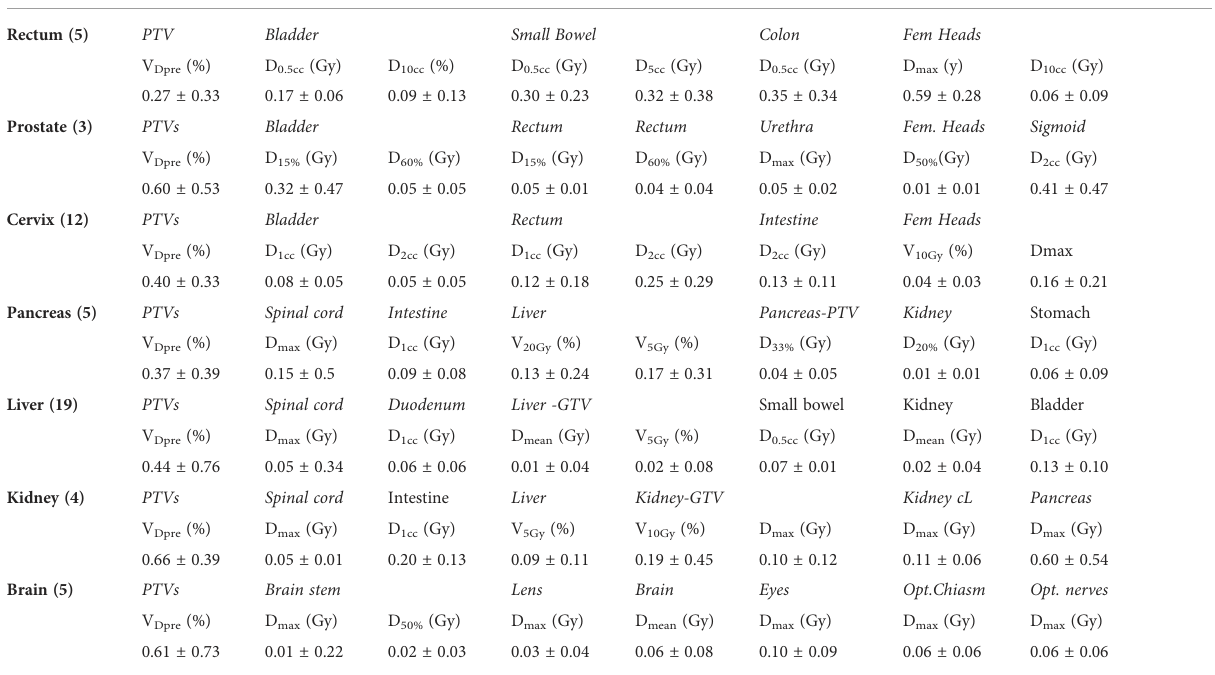
TABLE 3 Absolute difference of CT vs. syCT targets and OARs DVH dosimetric parameters (mean and standard deviations) for 54 out of 61 patients, resulting in tolerance at the fi rst CT vs. syCT plan comparison. Site (no.) CT vs. SyCT absolute dosimetric difference for targets and